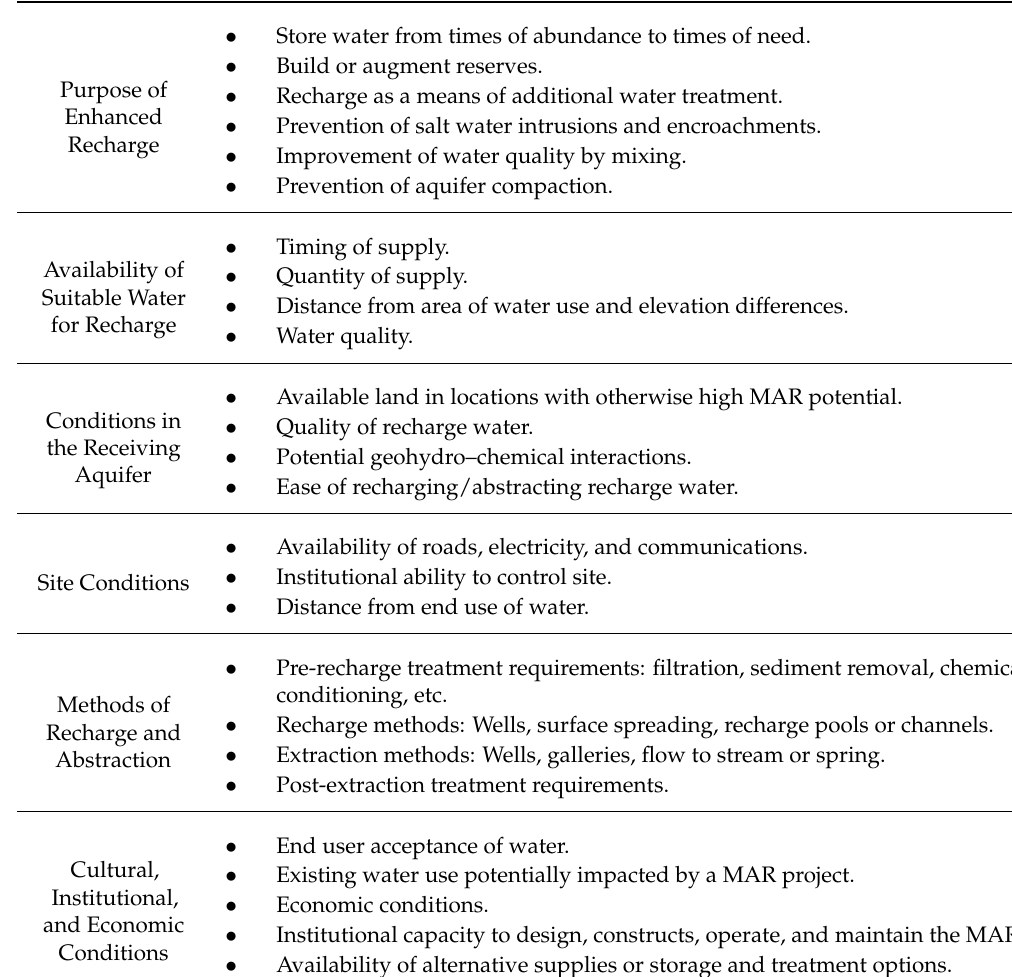
Table 1. Critical factors in the designing and implementing of the Managed aquifer recharge (MAR)